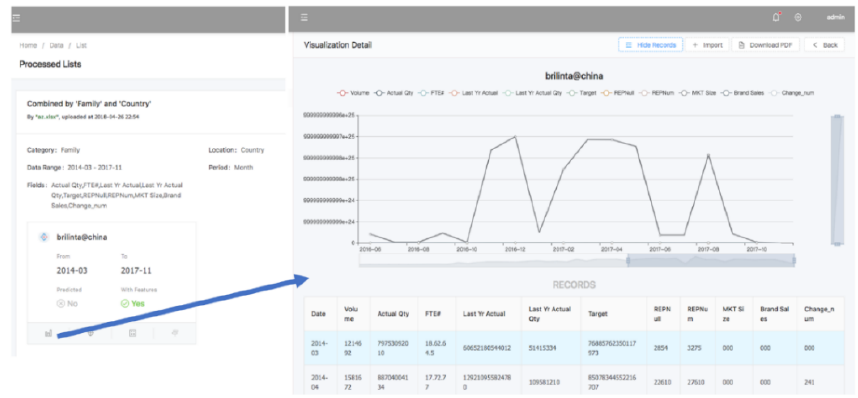
Figure A4. Loading the real sales prediction data set (csv or Excel format). View of the data import, data edit, and data group modules.